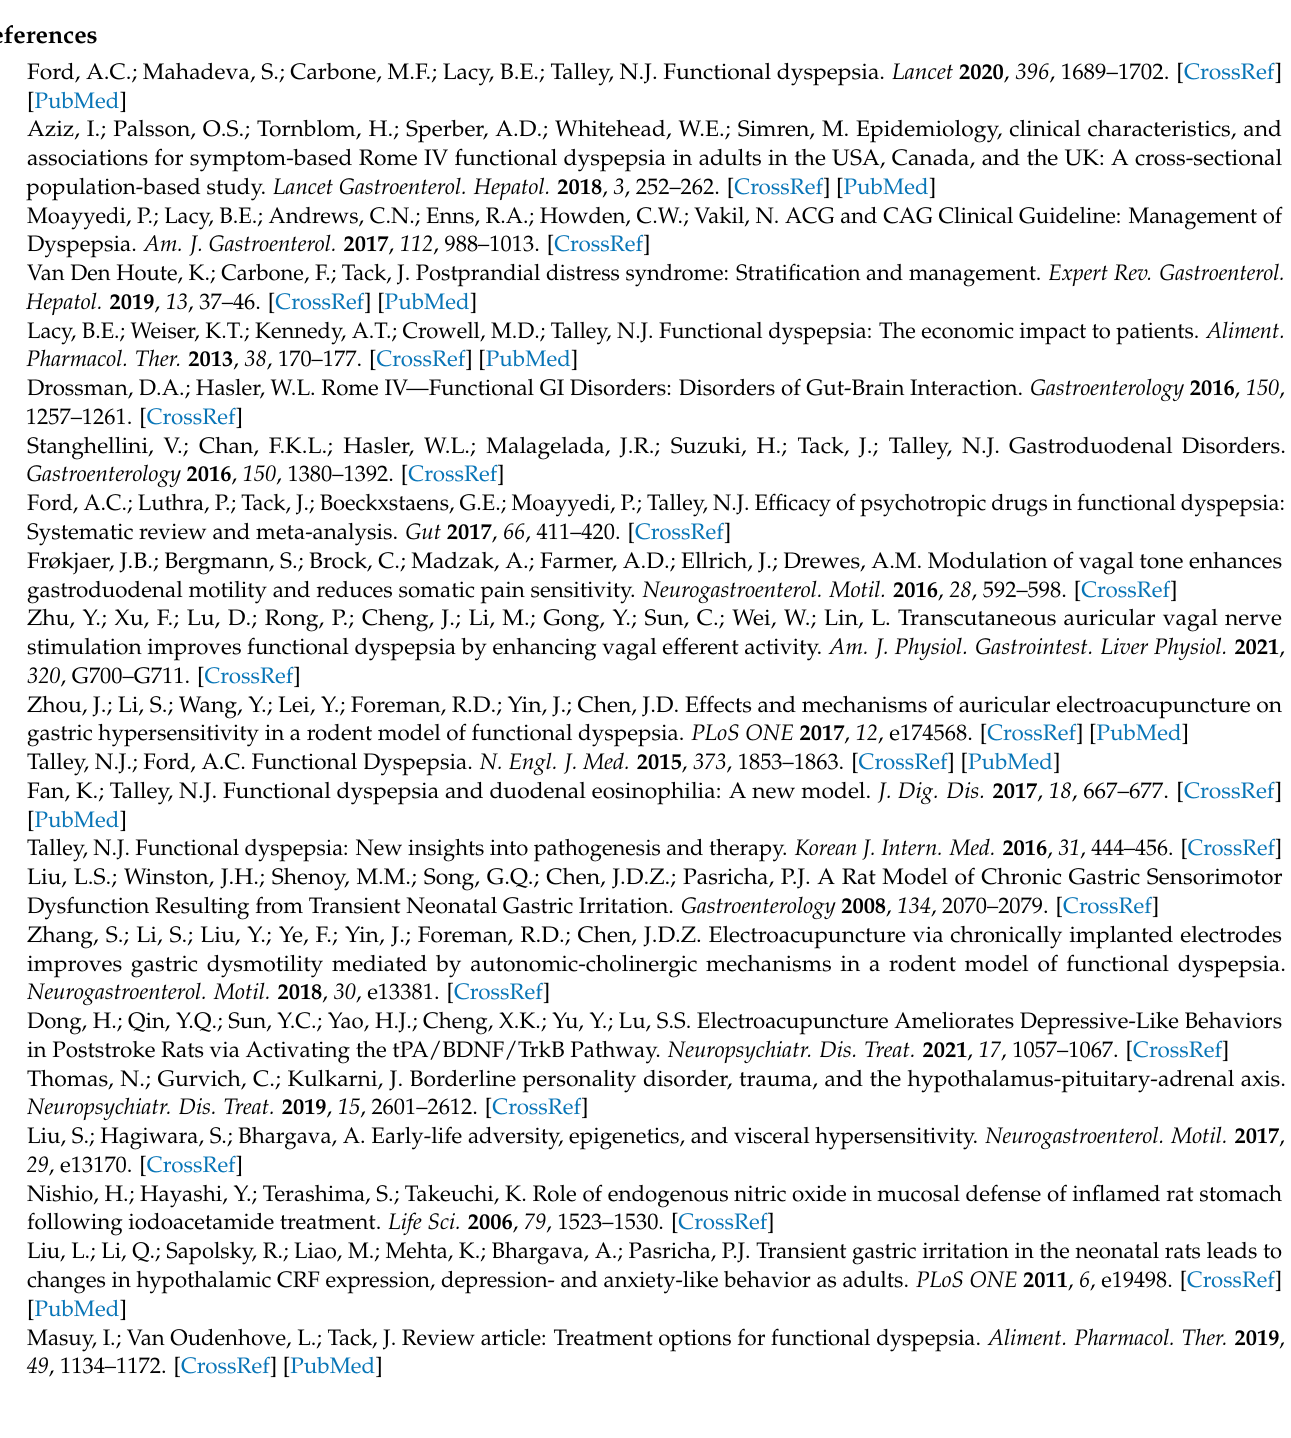
between target protein and internal reference protein was